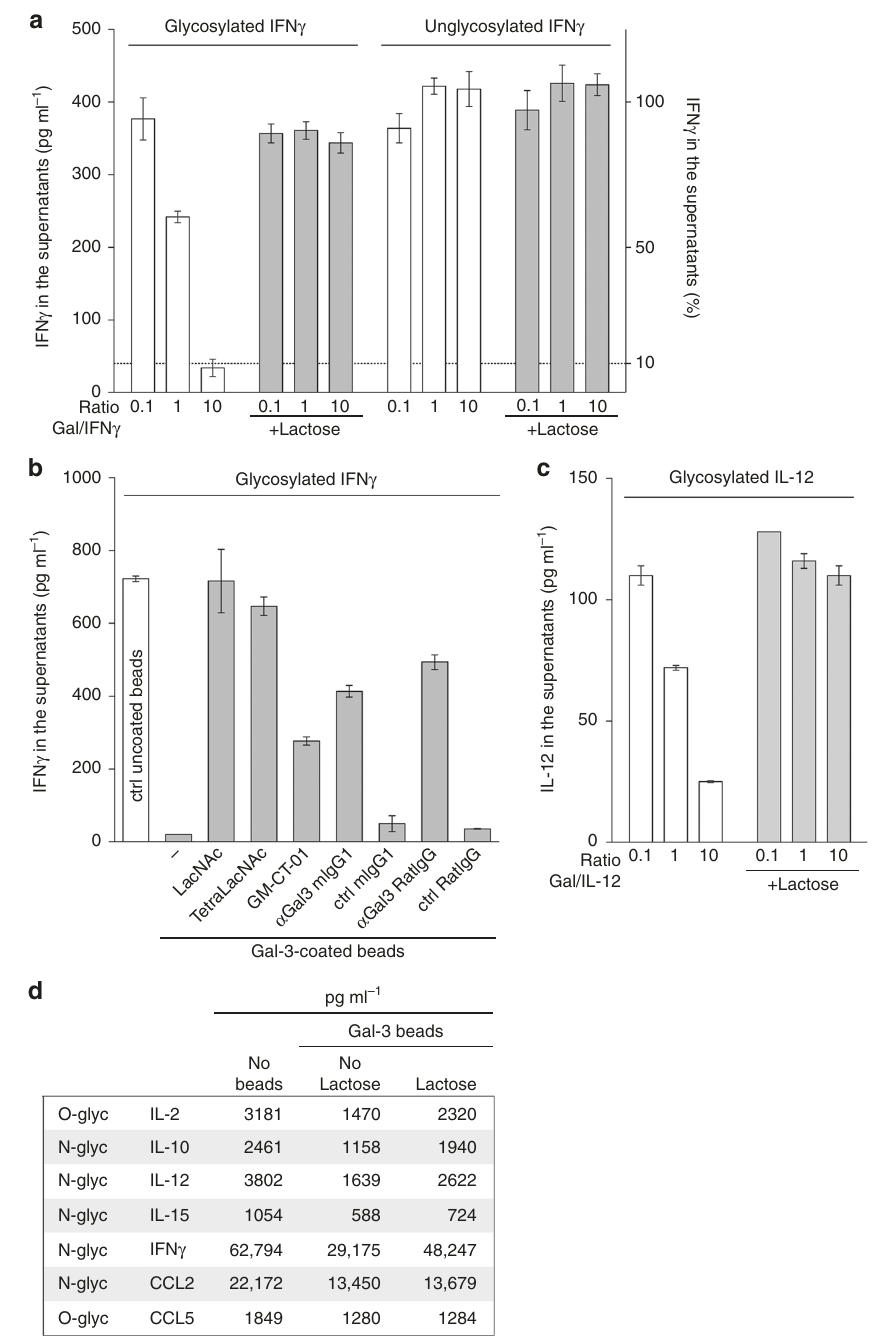
Fig. 1 Binding of human glycosylated cytokines to galectin-3-coated beads. Ratio refers to molar ratio. a hIFN γ measured by ELISA in the supernatant after incubation with galectin-3-coated beads in the presence or absence of 100 mM lactose. The glycosylated IFN γ was produced in CHO cells and the unglycosylated IFN γ was produced in E. coli . Mean ± SD of one representative experiment of 8 (glycosylated IFN γ ) or 2 (unglycosylated IFN γ ), performed in duplicates. The dotted line stresses that more than 90% of the glycosylated IFN γ was retained when mixed with 10 times more galectin-3-coated beads. b Glycosylated IFN γ measured by ELISA in the supernatant after incubation with galectin-3-coated beads and different galectin antagonists (LacNAc 5 mM, TetraLacNAc 30 μ M, GM-CT-01 100 μ g ml − 1 ), anti-galectin-3 antibody or a control isotype (10 μ g ml − 1 ). Mean ± SD of one representative experiment of three. c Glycosylated hIL-12 measured by ELISA in the supernatant after incubation with galectin-3-coated beads in the presence or absence of 100 mM lactose. Mean ± SD of one representative experiment of three, performed in duplicates. d Cytokines and chemokines measured in a human synovial fl uid collected from a rheumatoid arthritis patient after incubation with galectin-3-coated beads in the presence or absence of 100 mM lactose. Note: glycosylated cytokines and chemokines were entirely glycosylated, containing no detectable unglycosylated